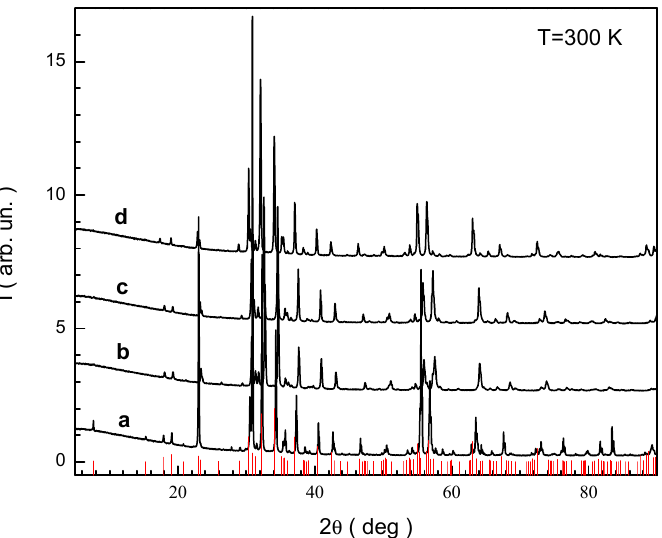
Figure 1. X-ray diffraction patterns at 300 K for the (a) BaFe 5.84 Ga 6.19 O 19 , (b) BaFe 6.26 Al 2.27 Cr 3.47 O 19 , (c) BaFe 6.11 Al 1.56 Cr 2.17 Ga 2.16 O 19 , (d) BaFe 6.19 Al 1.25 Cr 1.57 Ga 1.74 In 1.26 O 19 . Red bars are the Braggs reflections for the initial BaFe 12 O 19 compound (PDF#43-0002). Table 2. Unit cell parameters of the obtained solid